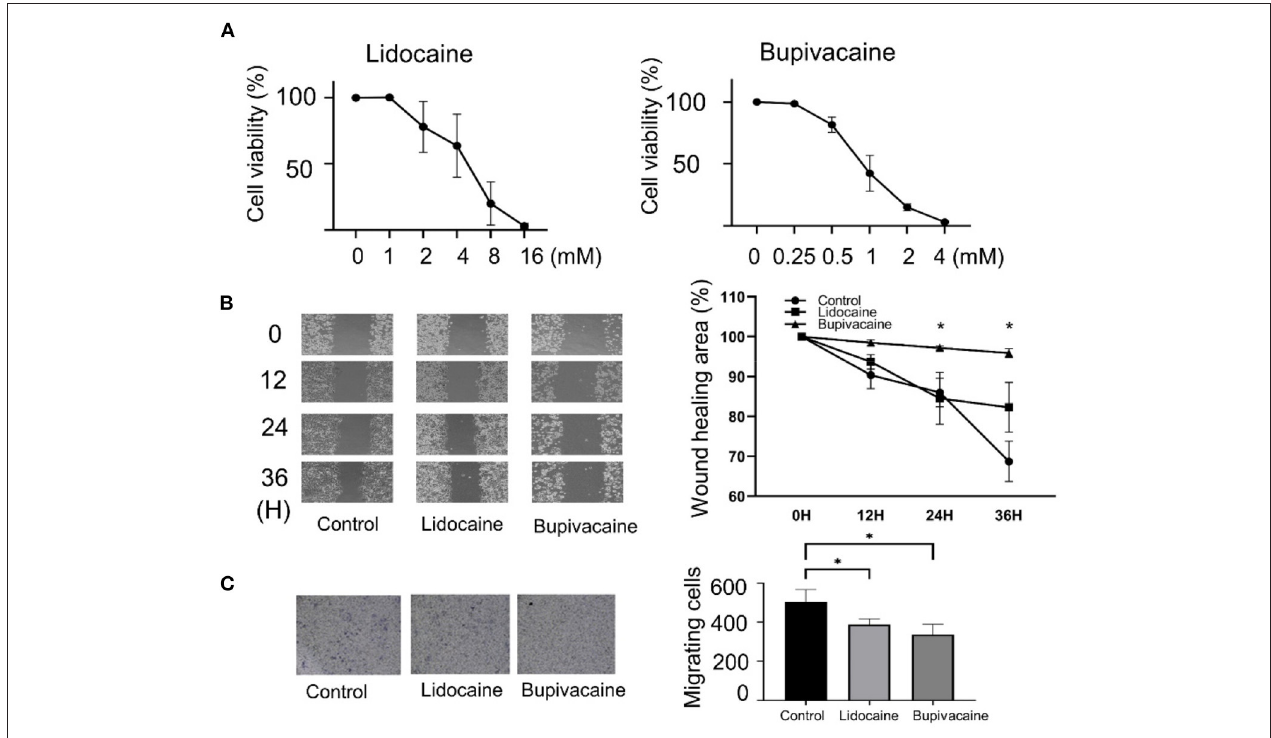
FIGURE 1 | Lidocaine and bupivacaine inhibited the proliferation and migration of MCF-7 cells. (A) Cell proliferation determined using the MTT assay. The growth of MCF-7 cells measured after 6h of treatment with serially diluted concentrations of lidocaine or bupivacaine. The proliferation rate was normalised to that at 0h. (B) Wound healing assay. Left: Images after 0, 12, 24, and 36h of treatment with lidocaine (4mM) or bupivacaine (1mM). Right: The migratory ability quantified using the reduction in wound size over time by ImageJ software v1.8.0. (C) Transwell migration assay. Right: The cells were seeded after 24h of treatment with lidocaine (4mM) or bupivacaine (1mM). Left: Cell migration measured after 36h of seeding. All data are presented as mean ± SD ( n = 3). * p < 0.05.